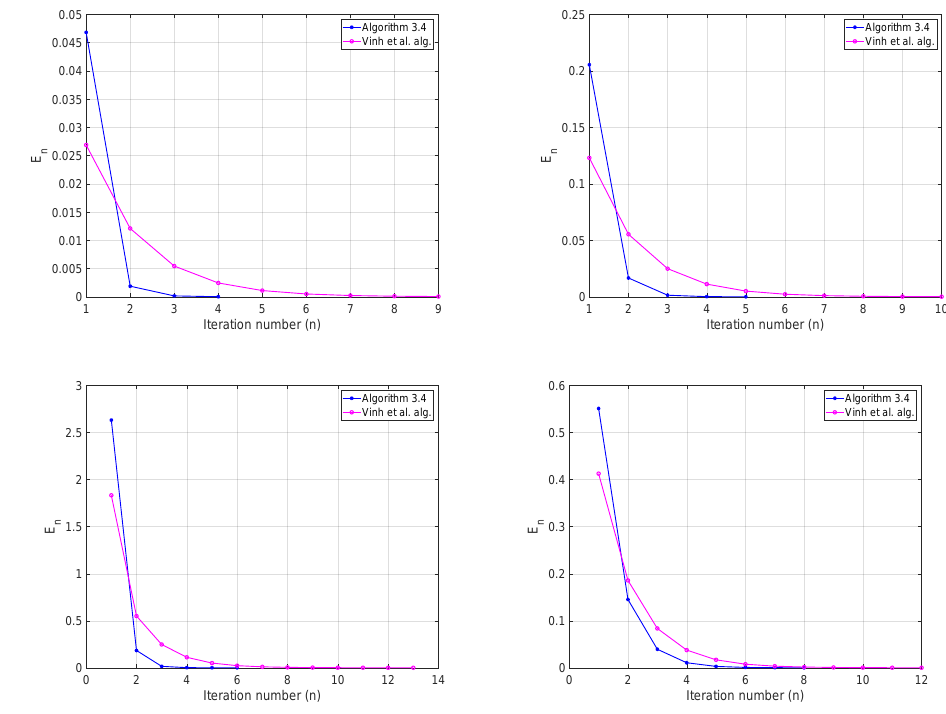
Figure 2. Example 2, Case I–Case IV;